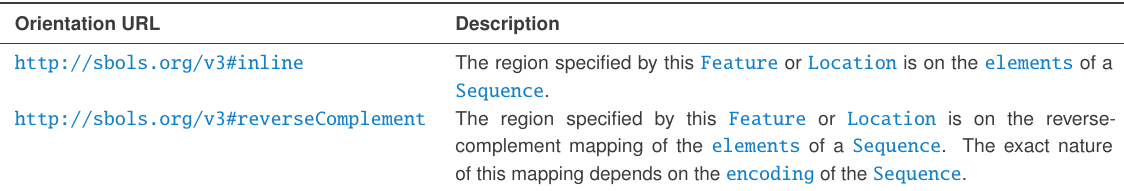
Table 6: Permitted alternative URL s for the orientation property. The URLs listed in Table 5 are preferred and SHOULD be used instead where possible.